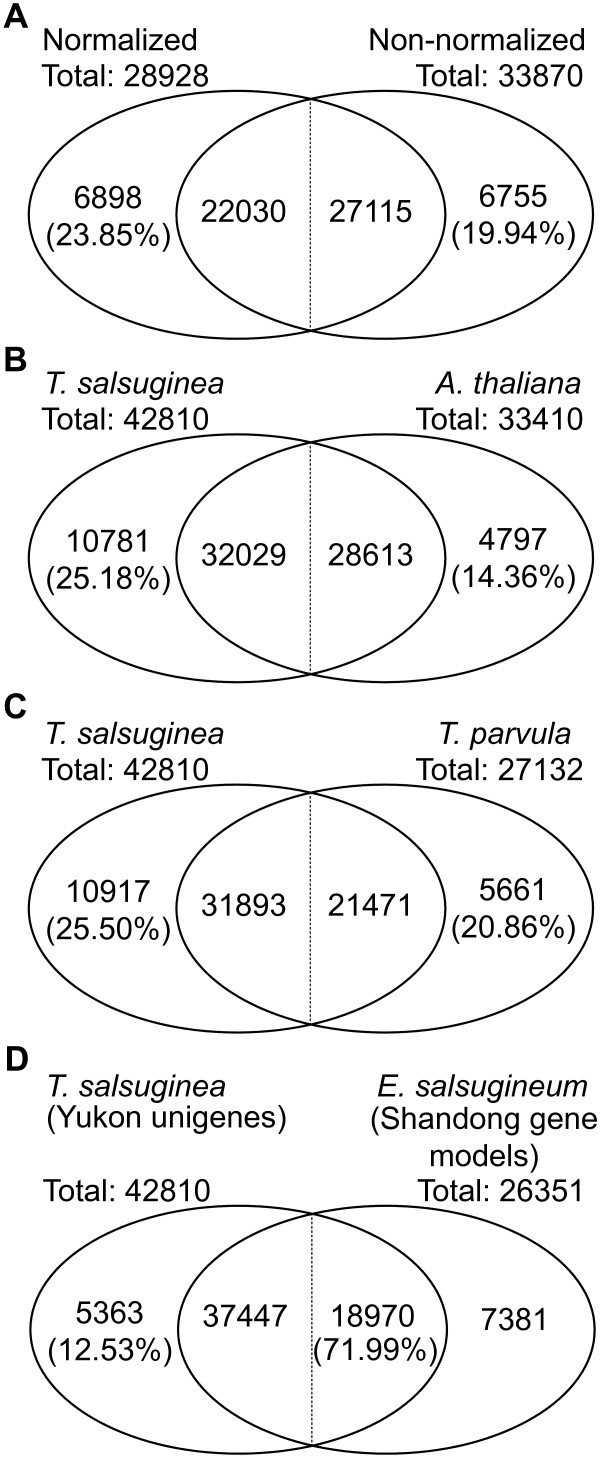
Similarity of T. salsuginea (Yukon) unigenes to Arabidopsis and T. parvula orthologs and T. salsuginea/Eutrema salsugineum (Shandong) gene models. Venn diagrams depicting the number of unique unigenes derived only from (A) normalized or non-normalized libraries, (B)T. salsuginea or Arabidopsis,(C)T. salsuginea or T. parvula (Schrenkiella parvula) orthologs, and T. salsuginea (Eutrema salsugineum) Yukon uniges or Shandong gene models (D). Vertical dividing lines indicate non-matched overlap values for both libraries and species due to the nature of the BLAST search algorithm.